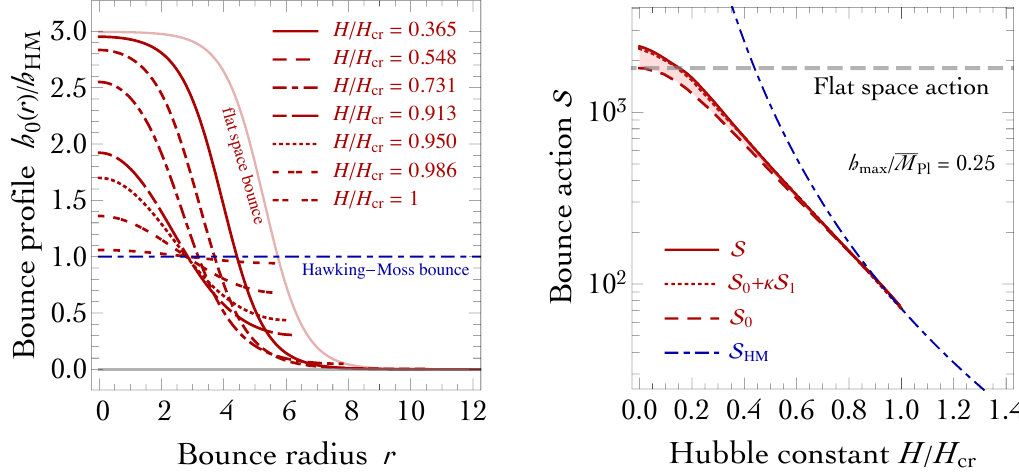
Figure 1 . We consider the renormalizable quartic potential of eq. (3.1) for quartic scalar coupling (cid:21) = 0 : 6, h true = 3 h max and vanishing non-minimal coupling to gravity. The results exhibit the typical features of the general case. The left panel shows the bounce h 0 ( r ) for di(cid:11)erent values of the Hubble constant H . As H is increased, the Coleman (cid:13)at-space bounce gradually tends towards the Hawking-Moss bounce, until only the Hawking-Moss solution remains at H > H cr . The right panel shows the Coleman and Hawking-Moss actions, comparing our weak-gravity expansion with the full numerical result. Figure 2 shows the actions of the extra multi-bounce